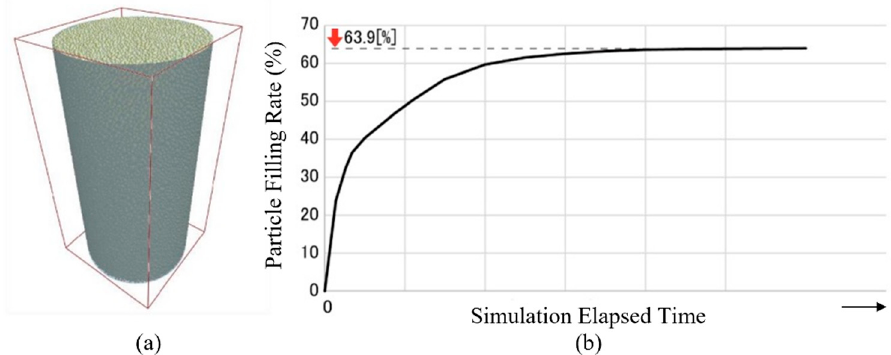
Figure 6. ( a ) Simulated DEM particle dispersion model, and ( b ) calculated particle filling rate.